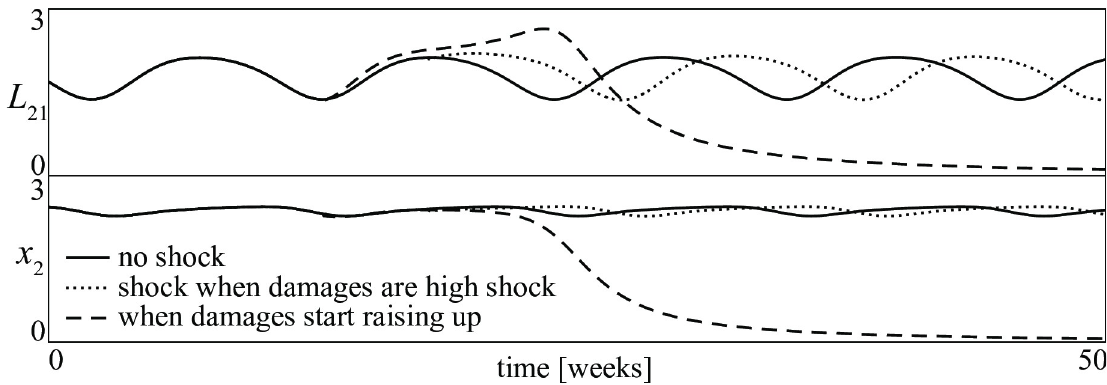
Fig 19. Losses L 21 of the D group and size x 2 of the A group in a D—A conflict. ( continuous curves ) without any intervention the conflict tends toward a periodic stalemate; ( dotted curves ) with a shock given when the damages are high the A group is not eradicated; ( dashed curves ) with a shock given when the damages start raising up the A group is